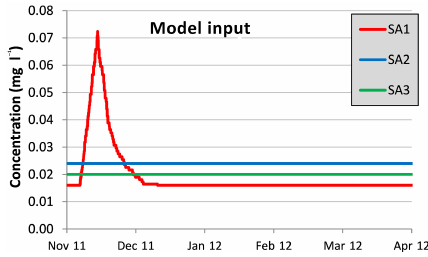
Figure 8. Model input signal to simulate a pulse of TDP occurring in SA1. SA2 and SA3 are inputted as constant signals based on mean observed TDP